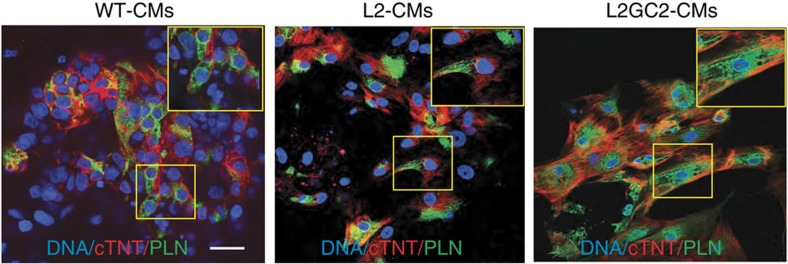
PLN protein distribution in cardiomyocytes.Representative immunofluorescence images showing the intracellular protein distribution of phospholamban (PLN) and cardiac troponin T (cTNT) in WT-, L2- and L2GC2-CMs. Nuclei were counterstained with DAPI. Scale bar, 25 μm.